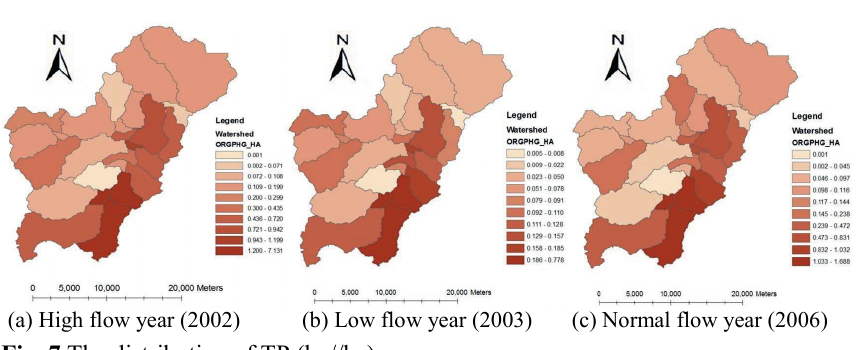
Fig. 6 The distribution of TN (kg//ha).